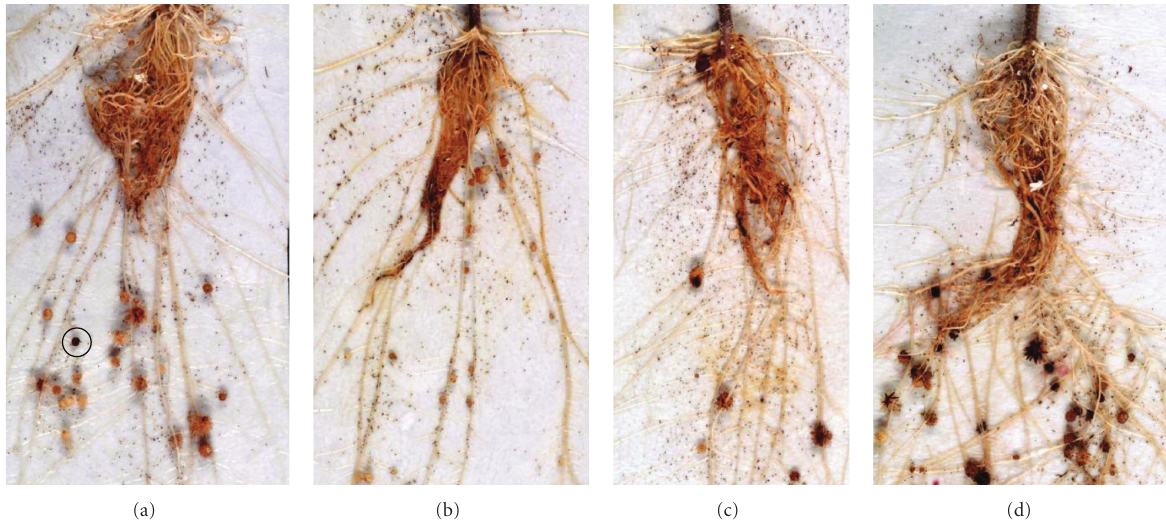
Figure 2: Broomrape tubercles attached to tomato roots showing pectinase enhanced virulence for F. compactum . The circle indicates a brown tubercle which was present before inoculation. Each plant bore an average of 16 ± 3 live tubercles. The pictures are from same experiment. F. compactum inoculum level was 3.67 × 10 6 propagules ml − 1 per inoculated